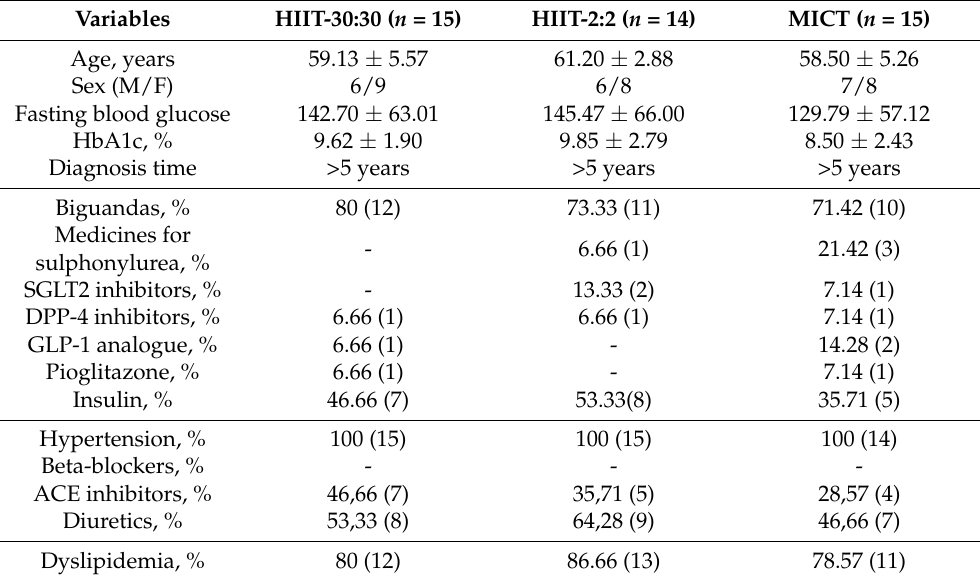
Table 1. Characteristics, risk factors, and medications of the study